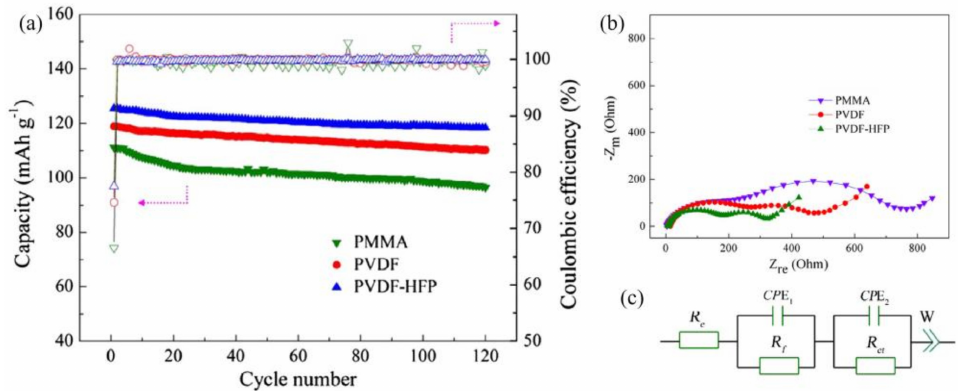
Figure 1. ( a ) Cycling performance and coulombic efficiency of LiFePO 4 /C electrodes with PMMA binder, PVDF binder, and PVDF-HFP binder at room temperature and 1C rate. EIS results of ( b ) the LiFePO 4 /C electrodes with PMMA binder, PVDF binder, and PVDF-HFP binder at frequencies from 0.01 Hz to 100 kHz and ( c ) equivalent circuit. Reprinted with permission from ref. [39]. Copyright 2014 Elsevier.